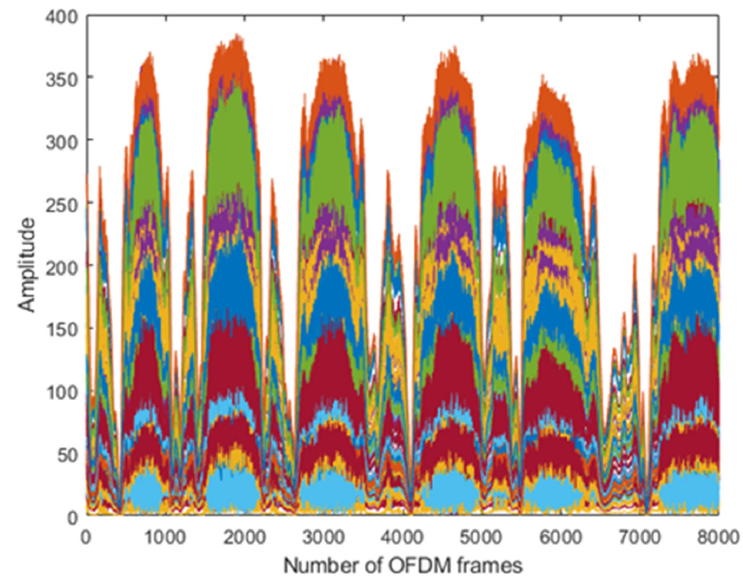
Figure 4. WCSI amplitude response of walking activity experiment.